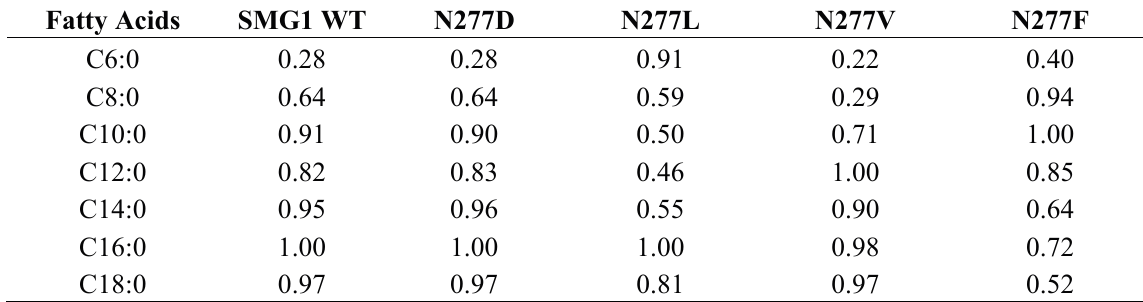
Table 3. The specificity constants (1/ α ) of each fatty